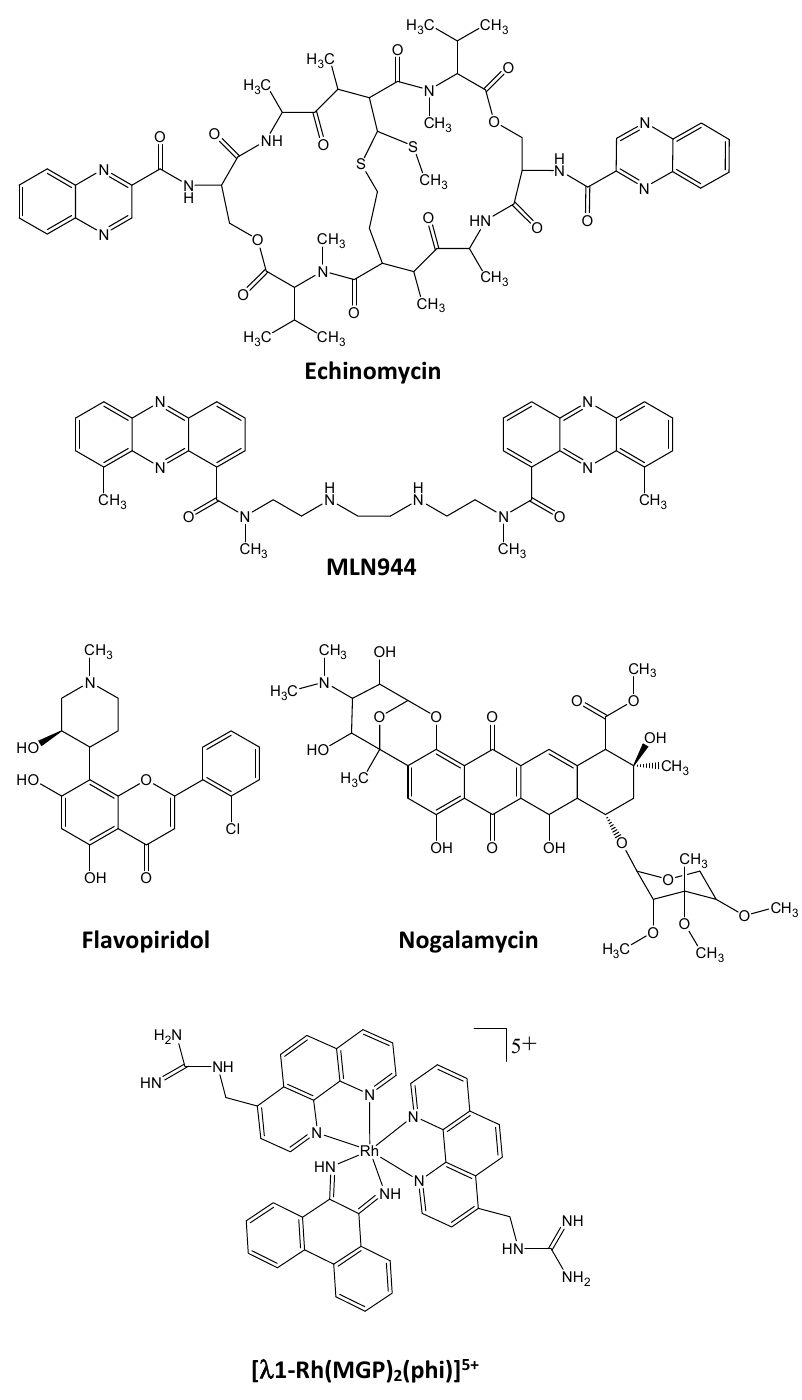
Figure 7. DNA intercalating drugs as inhibitors of transcription factors/DNA binding.